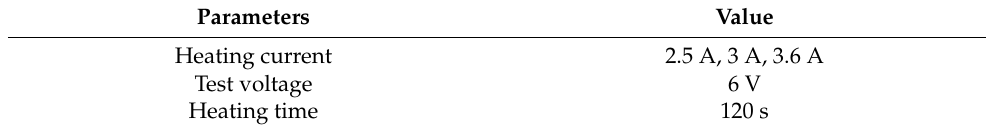
Table 5. Test conditions of I g.